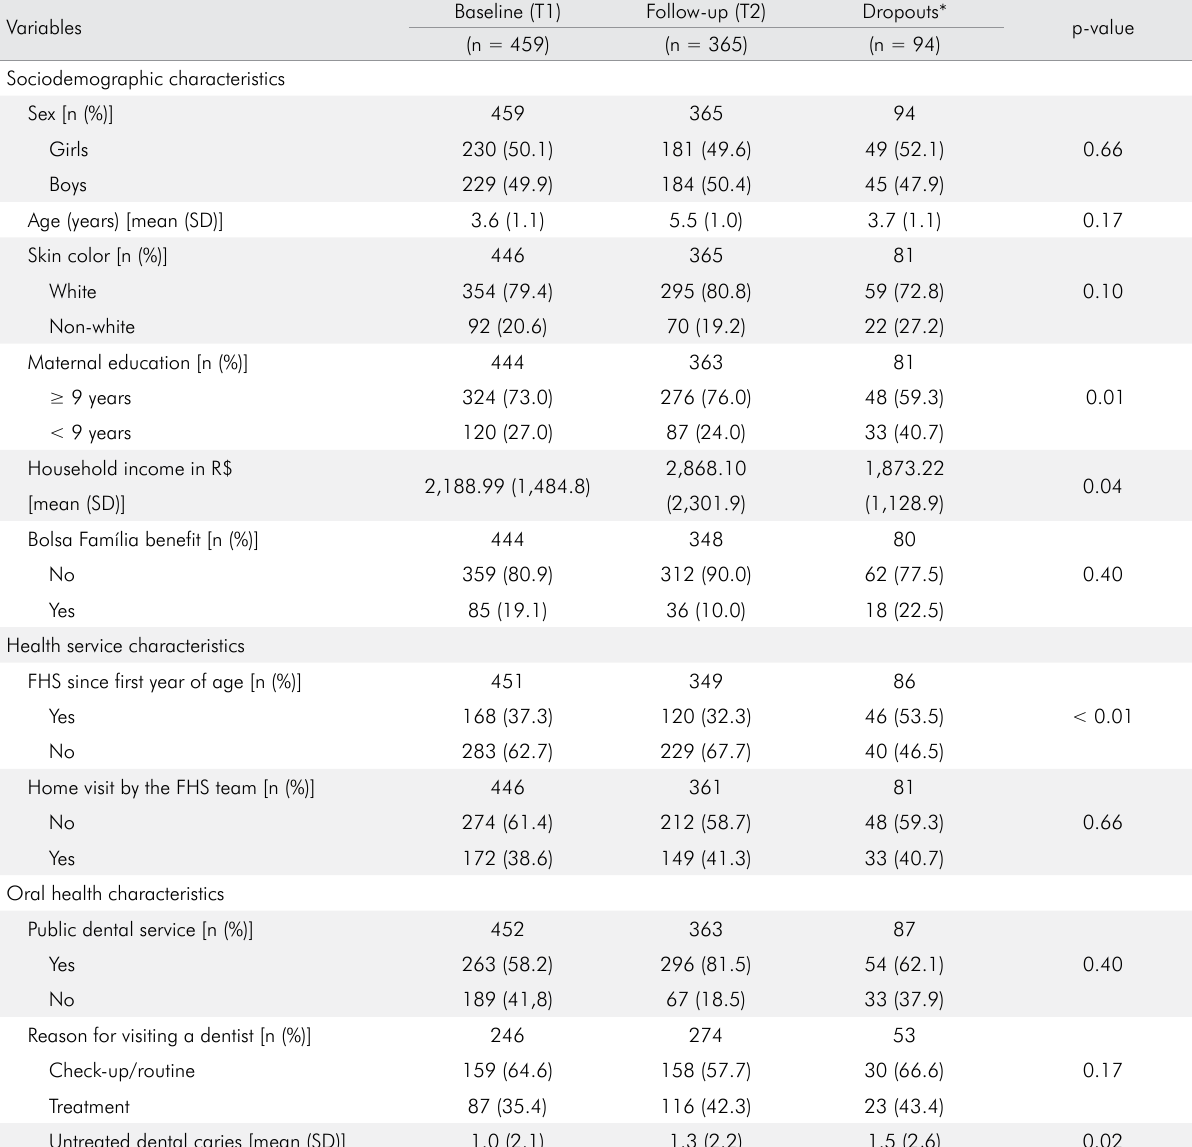
Table 1. Sociodemographic, health service, and oral health characteristics of the participants and dropouts.